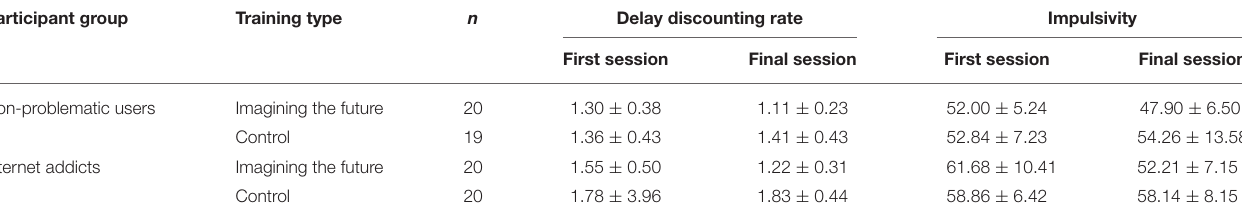
TABLE 2 | Different participant groups in the experimental and control conditions showing decreases in the delay discounting rates and impulsivity ( M ± SD ). Participant